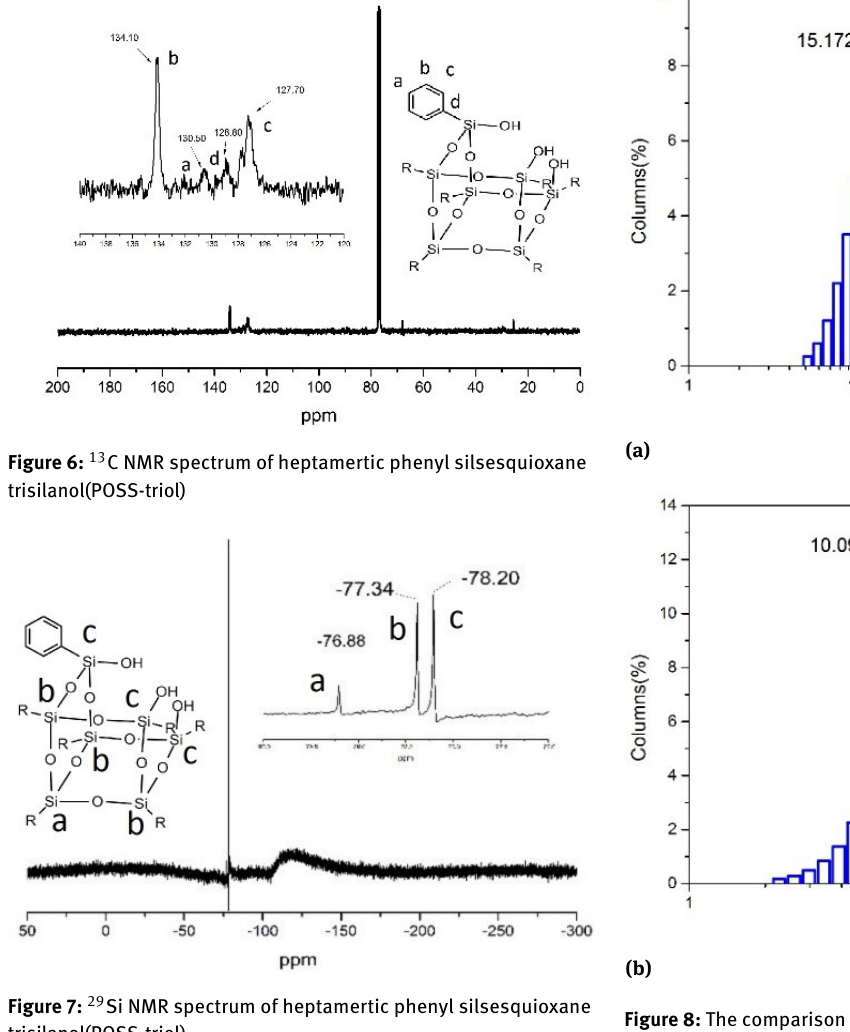
Figure 8c): the composite particle XRD diagram, there